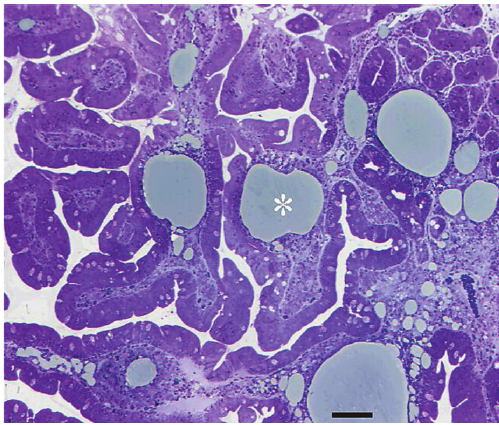
Figure 16: Accumulation of large lipid droplets (asterisk) in the lamina propria of intestinal villi. Semi-thin resin section, scale = 0.1mm. Courtesy of Ladislav Kubeˇs, MD, PhD. Reproduced with permission from Bureˇs and Rejchrt [42].